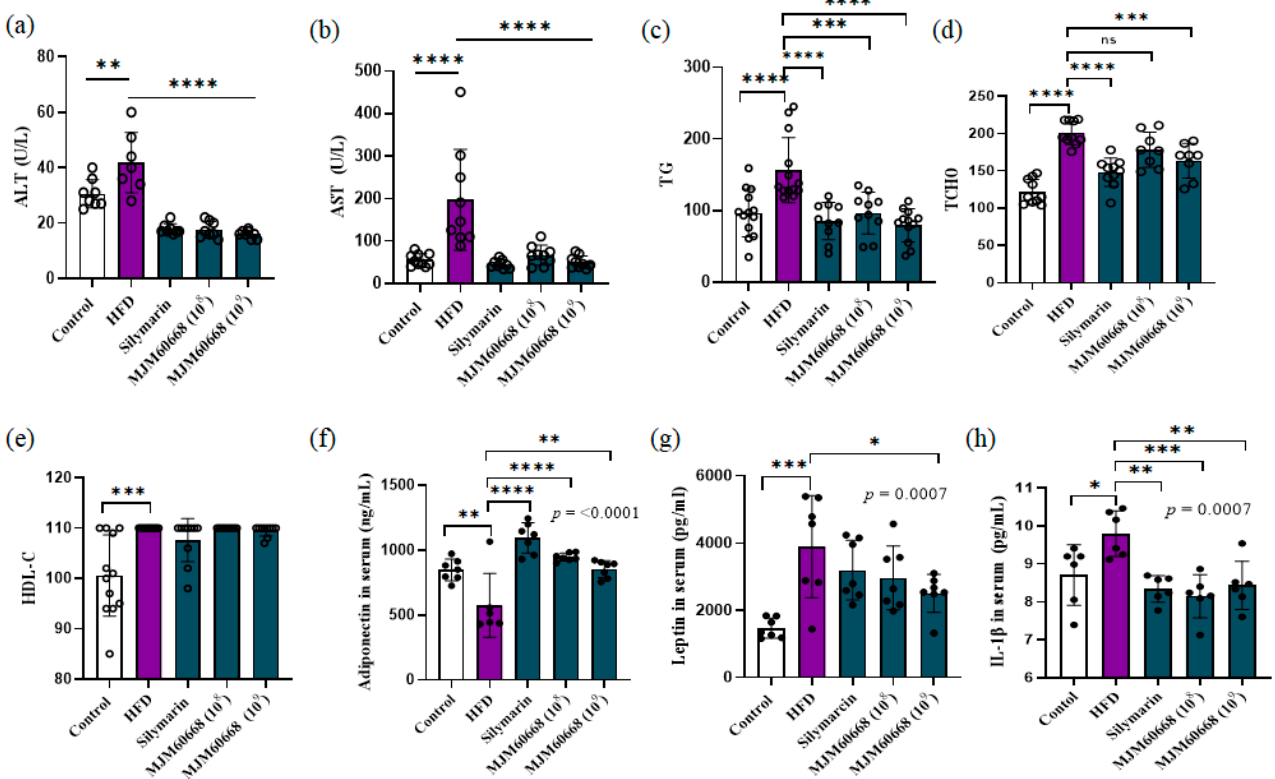
Figure 5. L. reuteri MJM60668 reduces hepatic lipid accumulation and liver injury in mice. ( a – e